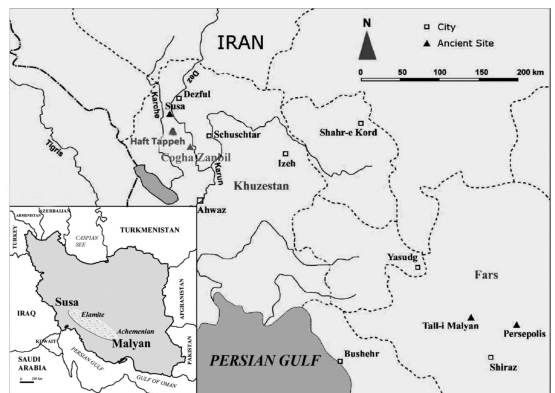
Figure 2. Geographic location of the Ziggurat Chogha Zanbil (Iran).